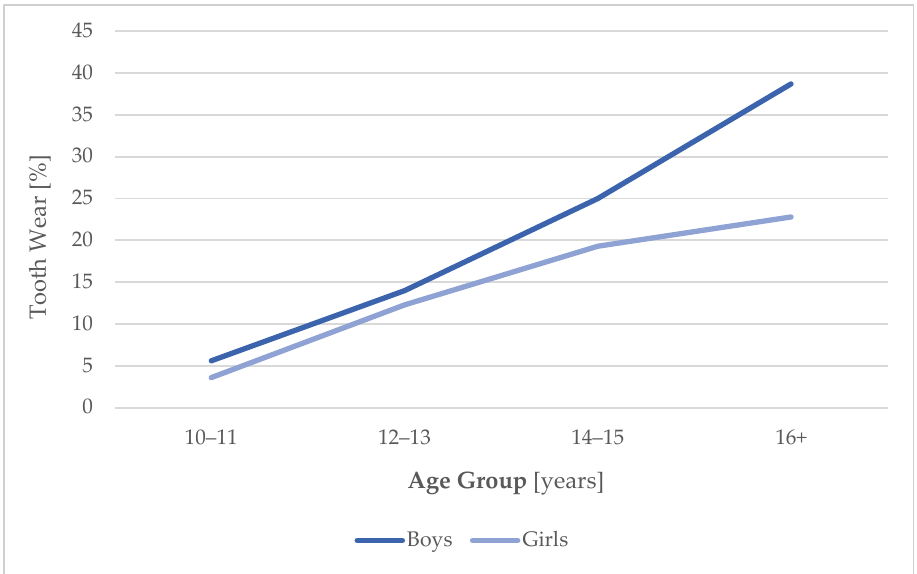
Figure 2. Age course of tooth wear prevalence in both sexes.